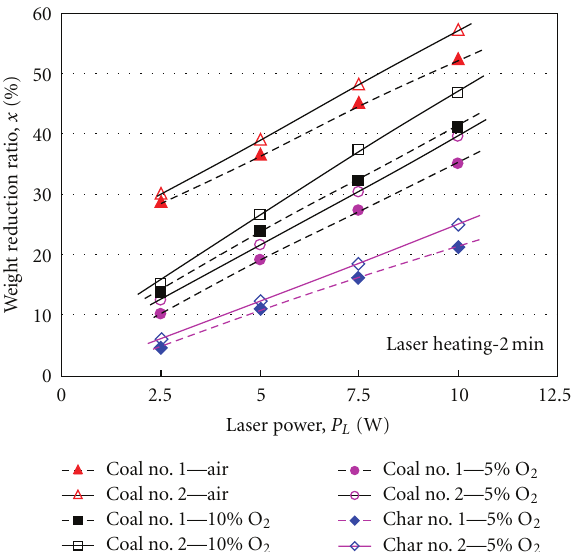
Figure 12: Comparisons of weight reduction ratio, x (%) with di ff erent samples and gases injection.